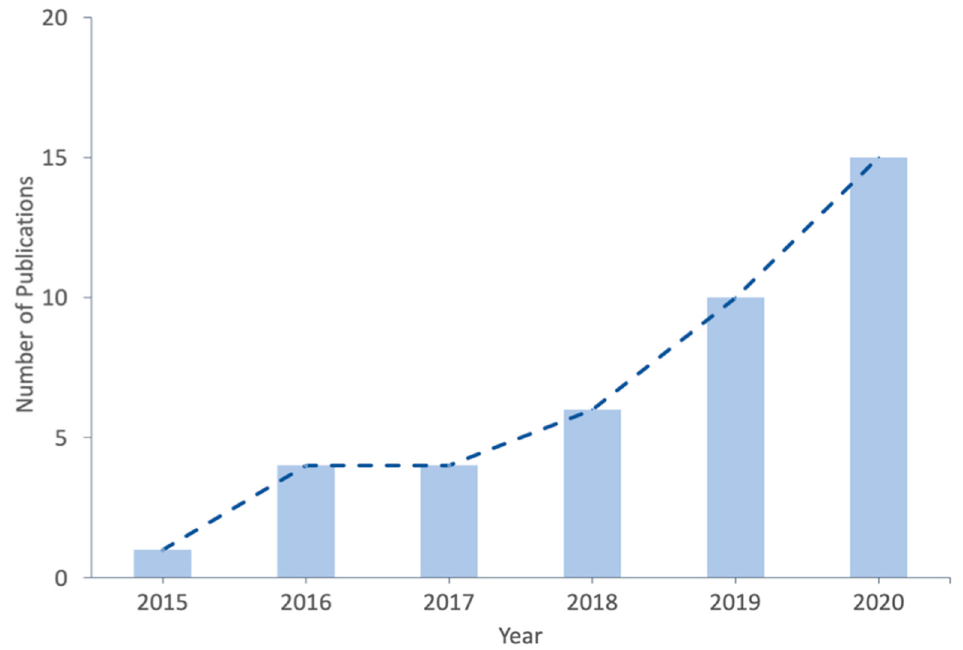
Figure 1. Organ-on-chip publications involving bioprinting from 2015 to 2020, based on search results in the PubMed database using search query: (organ-on-a-chip) AND (bioprinting).